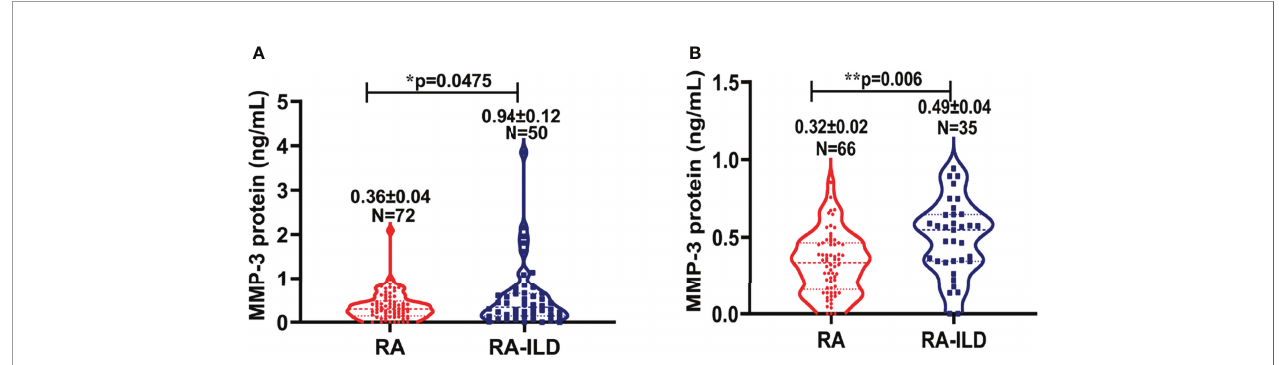
FIGURE 4 | Plasma concentration of MMP-3 protein in RA versus RA-ILD patients. (A) The plasma level of MMP-3 protein in RA as well as RA-ILD patients in training cohorts. The level of MMP-3 protein was shown in plasma of RA and RA-ILD patients. The plasma MMP-3 level in RA-ILD was signi fi cantly increased compared to in RA control subjects (p = 0.0475). (B) The plasma level of MMP-3 protein in RA as well as RA-ILD in validation cohorts. The level of MMP-3 protein was shown in plasma of RA-ILD and non-ILD RA patients. The plasma MMP-3 level in RA-ILD was signi fi cantly increased relative to RA patients without ILD (p = 0.006). Bars indicate average protein levels in each group. *p < 0.05; **p < 0.01. Data represent the mean ± SEM in each group.